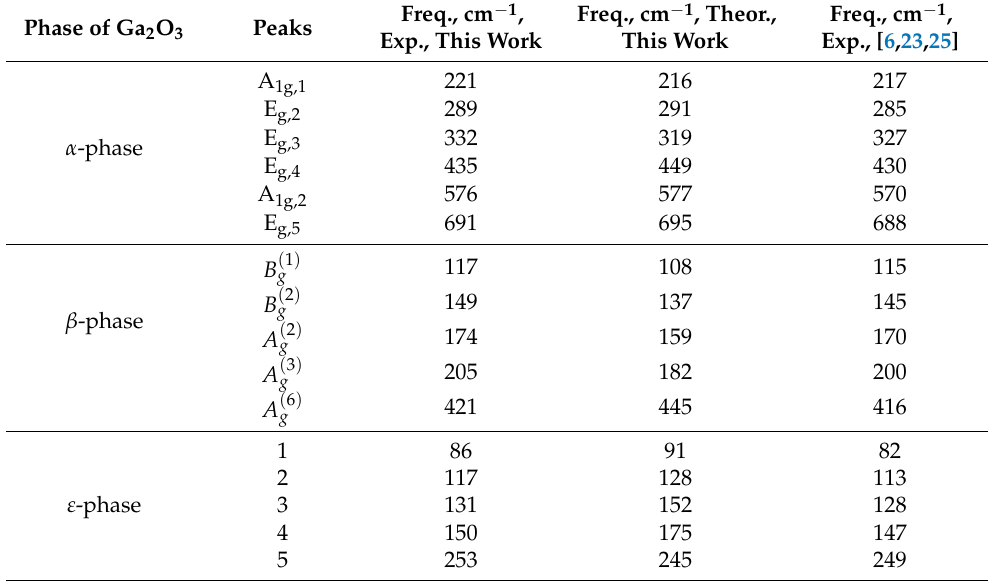
Table 1. The values of the frequencies of the main Raman peaks of all three phases, by which they can be identified. Freq., cm − 1 , Freq., cm − 1 , Theor., Freq., cm − 1 , Phase of Ga 2 O 3 Peaks Exp., This Work This Work Exp., [6,23,25] A 1g,1 221 216 217 E g,2 289 291 285 E g,3 332 319 327 α -phase E g,4 435 449 A 1g,2 E g,5 691 ( 1 ) B g β -phase ( 2 ) A g